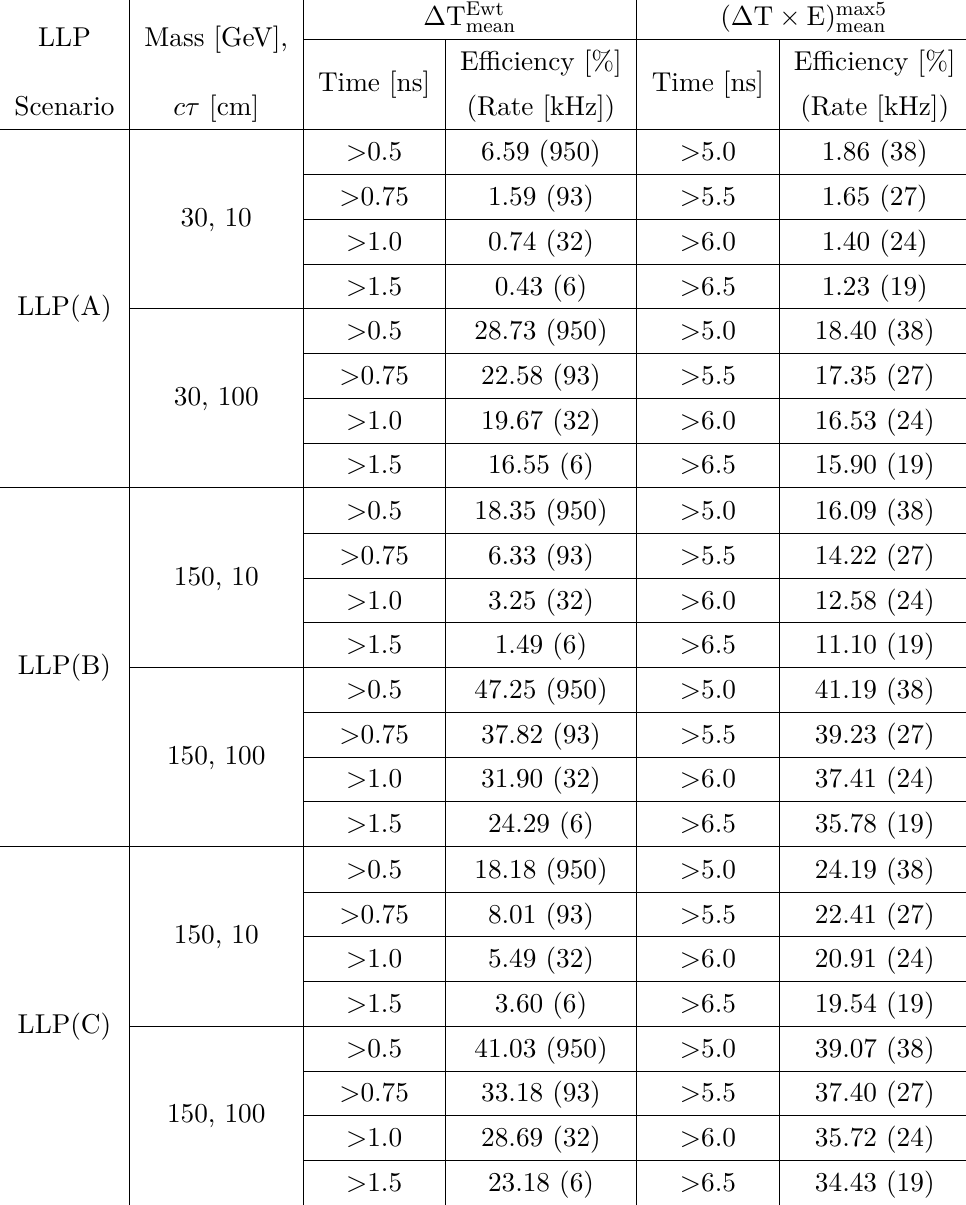
Table 1 . Signal efficiencies and background rates for LLP scenarios (A), (B) and (C) benchmarks with LLP of mass 30 GeV and 150 GeV respectively with decay lengths 10 and 100 cm for various timing thresholds on ∆T ewt and (∆T × E) max 5 mean mean